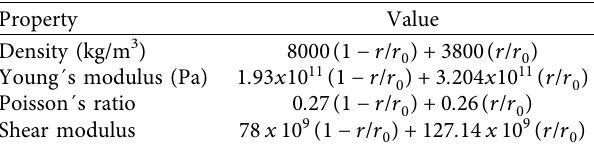
Table 3: Mechanical and physical properties of the FGM (316 steel+Al 2 O 3 ).